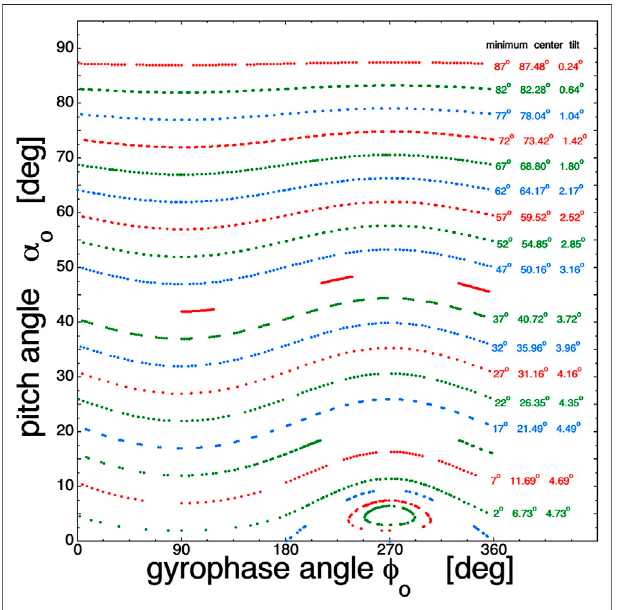
FIGURE 3 | The data from Figure 2 is plotted and fi tted. (See text for an